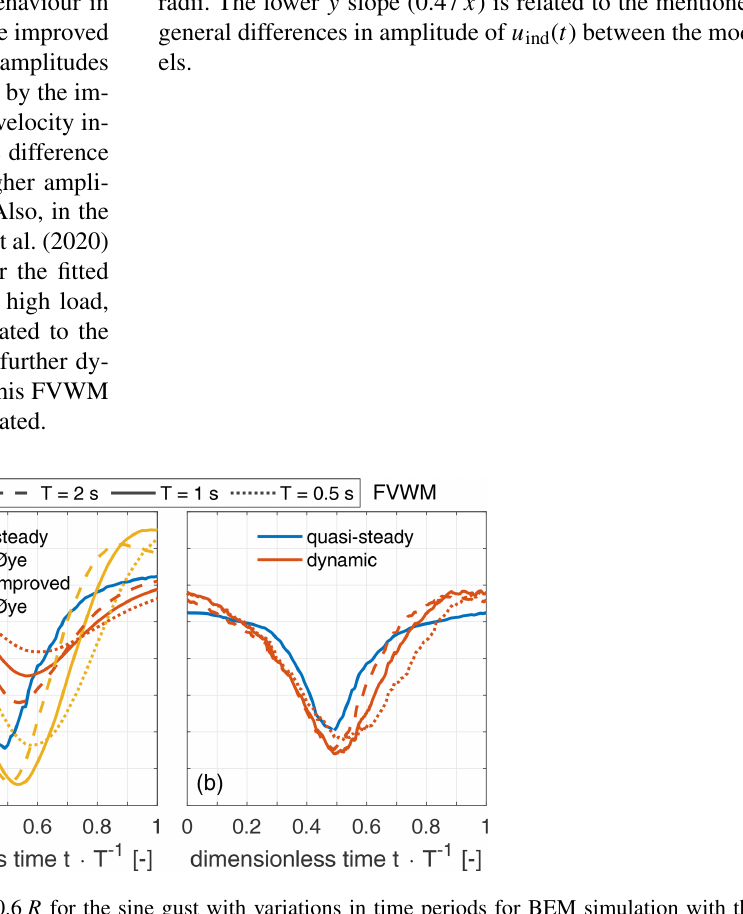
Figure A1. Steady and dynamic induced velocity at 0.6 R for the sine gust with variations in time periods for BEM simulation with the original and improved Øye dynamic inflow model (a) and FVWM simulation (b)